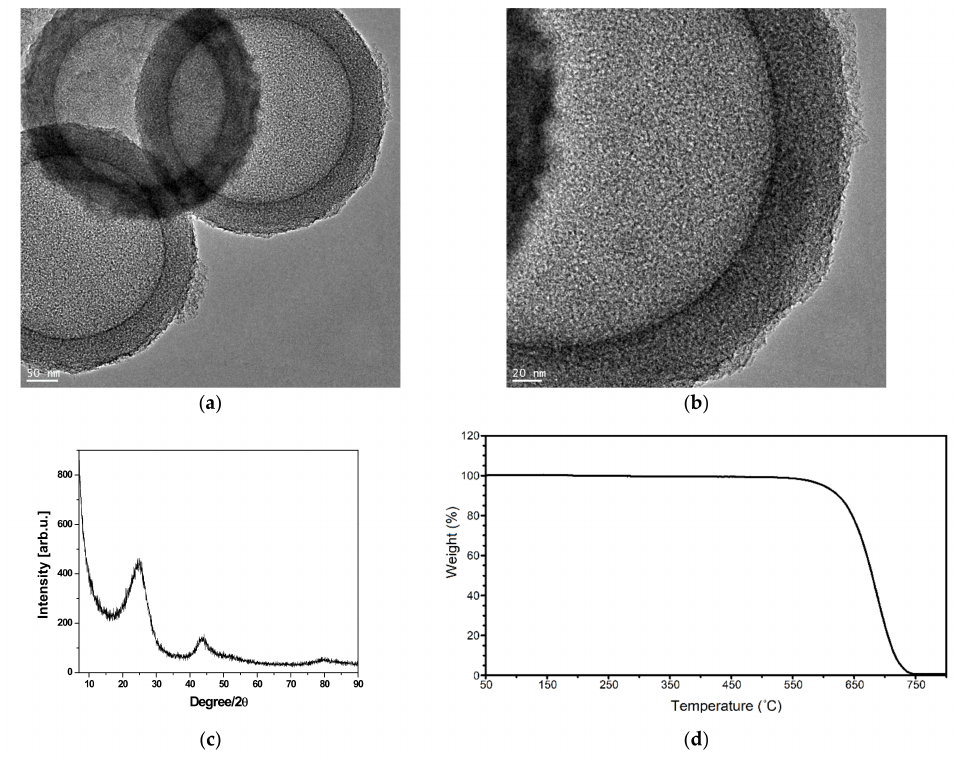
Figure 1. Characterization of carbon spheres: ( a ) transmission electron microscopy (TEM) pictures of a carbon spheres group; ( b ) TEM pictures of single carbon sphere; ( c ) a wide angle X-ray powder diffraction spectrum; and ( d ) thermogravimetric